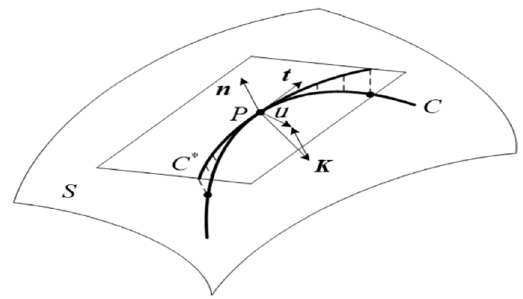
Figure 1. The curve curvature.